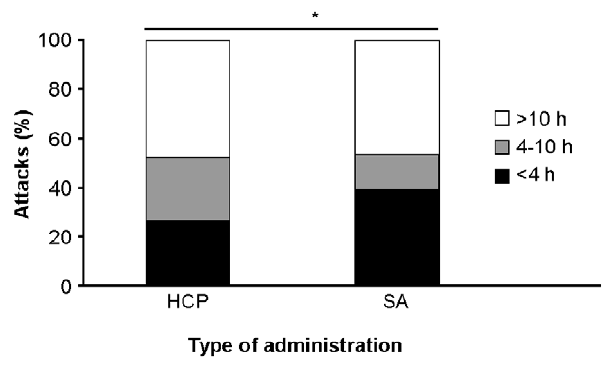
Figure 5. Self-administration of icatibant resulted in shorter duration of attack. Figure shows duration of attack by type of administration. n=17, 17 and 32 for attacks lasting , 4 hours, 4–10 hours and $ 10 hours for HCP-administered patients, respectively; n=57, 20 and 69 for attacks lasting , 4 hours, 4–10 hours and $ 10 hours for self-administered patients; * p =0.047 for self-administration versus HCP-administration; HCP, healthcare professional; SA, self-